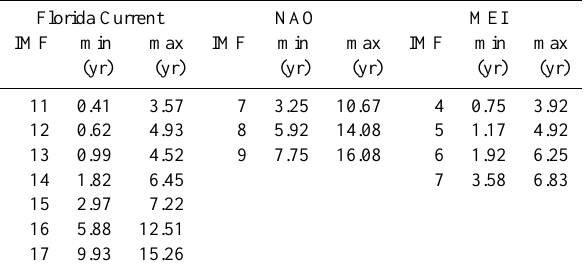
Table 1. IMF minimum and maximum instantaneous frequency ex- pressed as periods in years.